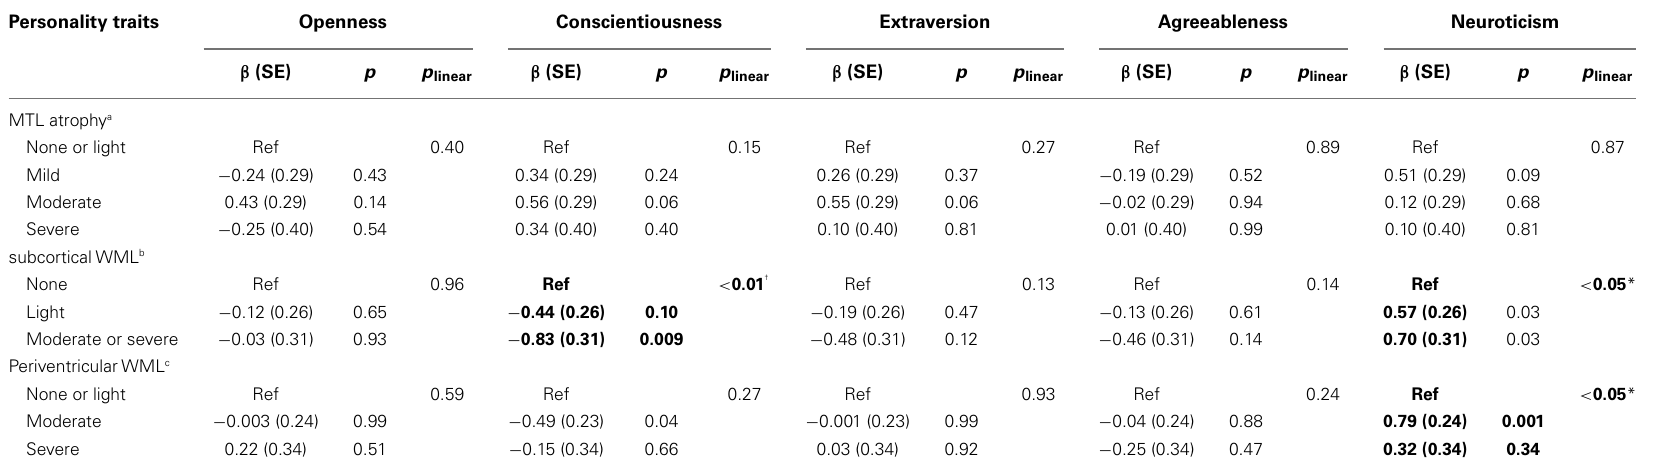
Table 6 |Association of personality traits and lacunes, MTL atrophy, subcortical, and peripheralWML, full adjusted model